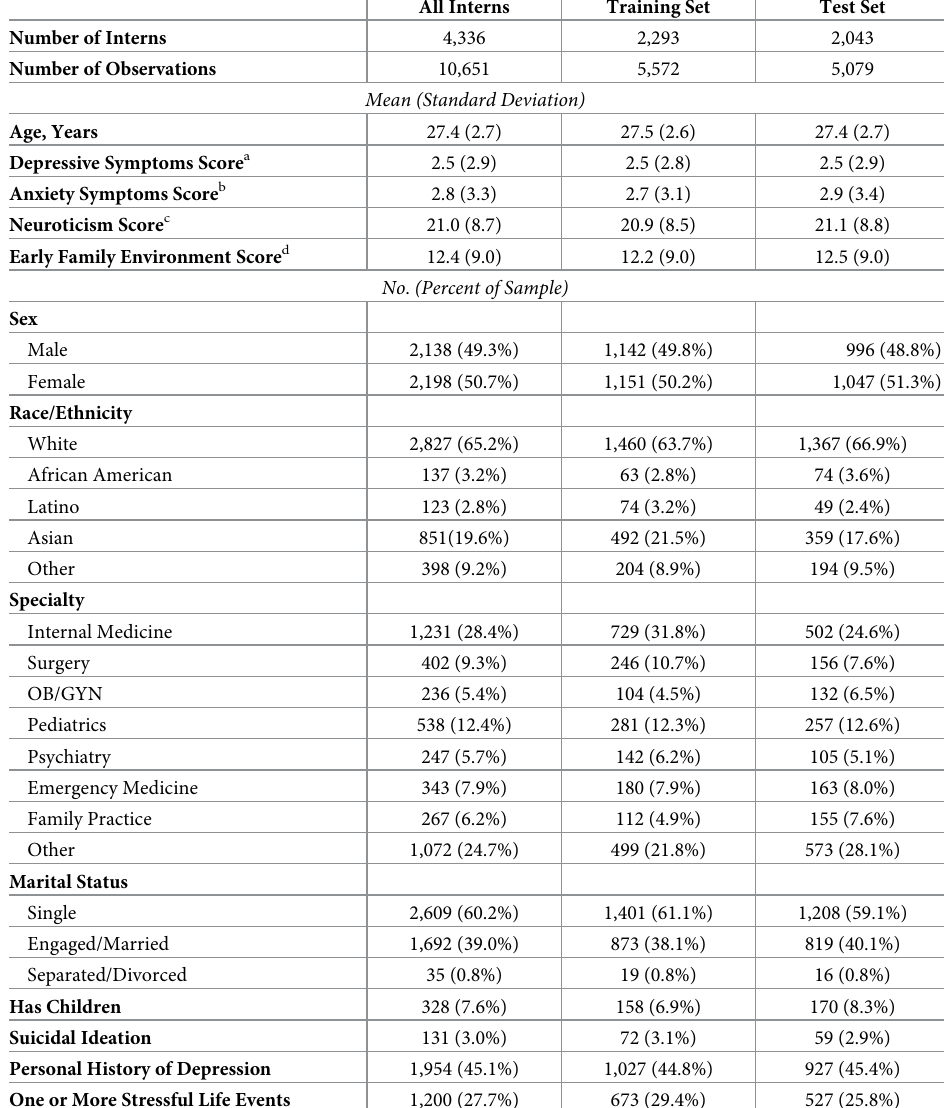
Table 1. Baseline characteristics of Intern Health Study participants entering residency programs across special- ties in the 2012–2014 ( n = 2,293) or 2015 ( n = 2,043) academic